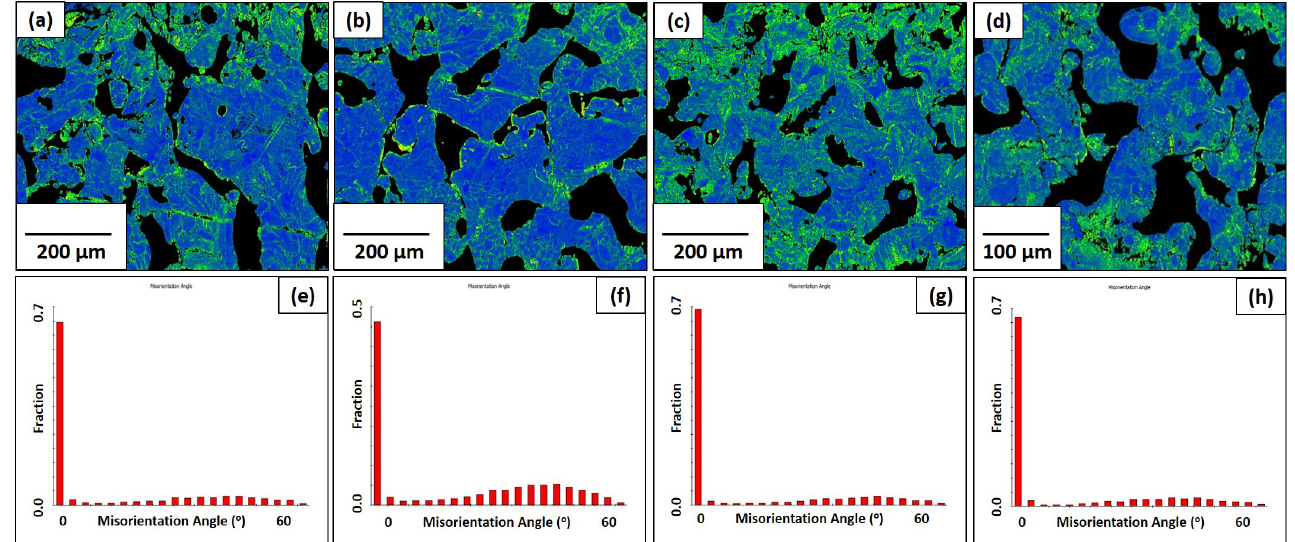
Figure 6. KAM maps for the pure molybdenum specimens in the observation direction at all four scan speeds: ( a ) 100 mm/s; ( b ) 200 mm/s; ( c ) 400 mm/s; ( d ) 800 mm/s. Grain orientation spread graphs for the pure molybdenum specimens in the observation direction at all four scan speeds: